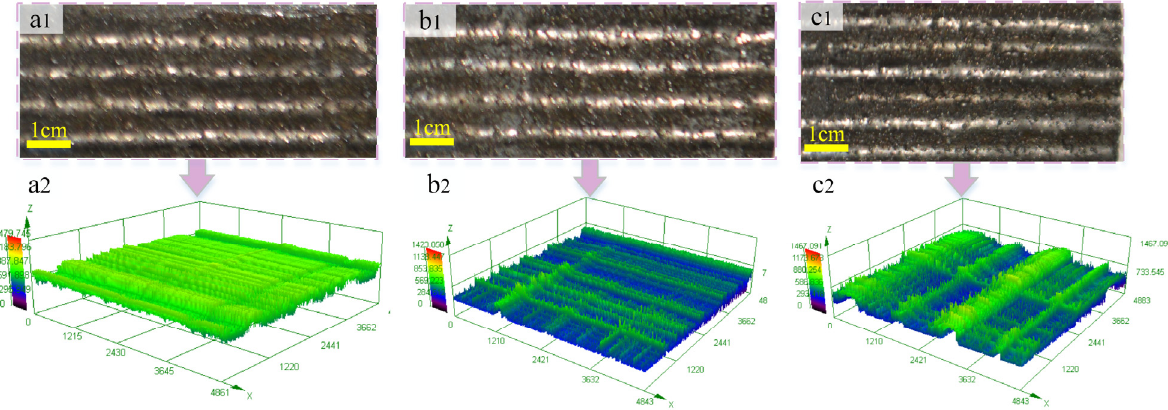
Figure 10. Morphologies of deposition layers under different lapping strategies: ( a ) Strategy I-1, ( b ) Strategy I-2, ( c ) Strategy I-3.